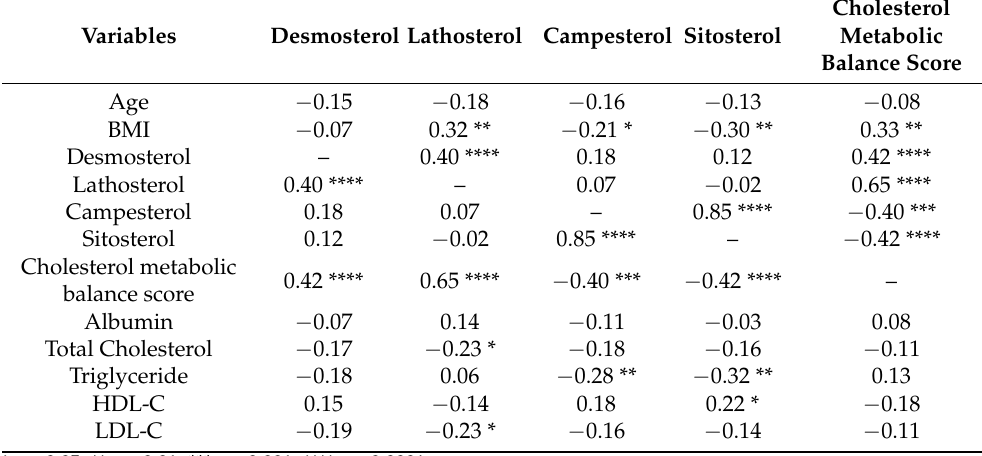
Table 3. Pearson correlation analysis between studied continuous variables.